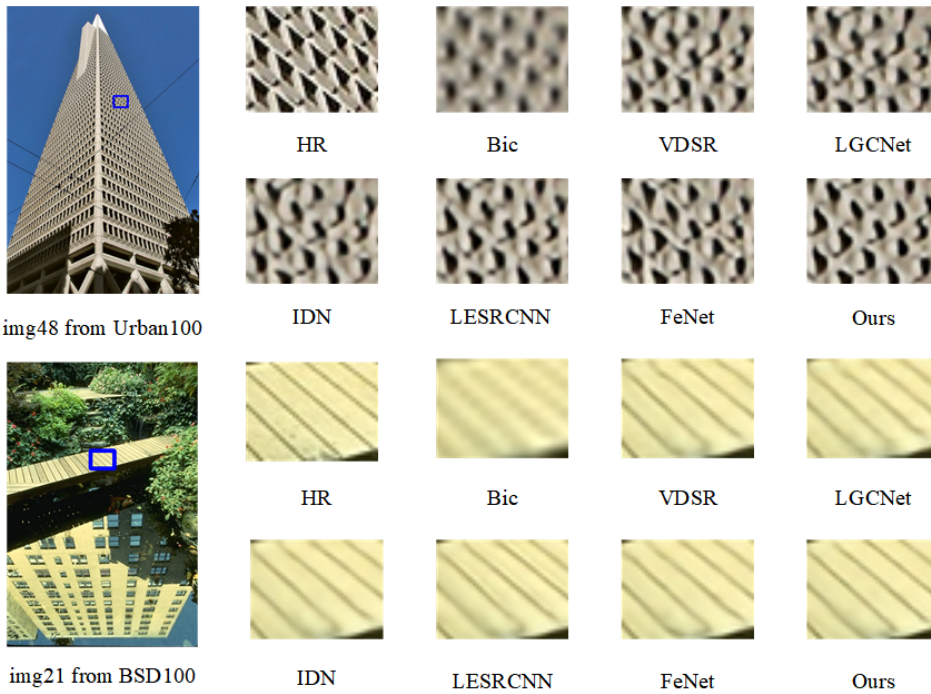
Figure 8. Visualization results of several SR methods and our proposed network, FDENet, on natural datasets for 3 SR. Zoom in with blue box for best view. ×